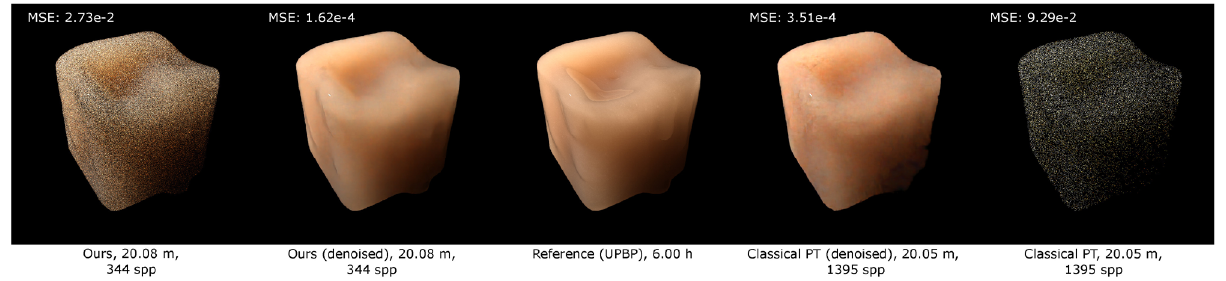
Fig. 9 Comparison of our method and path tracing with equal time for the Candle